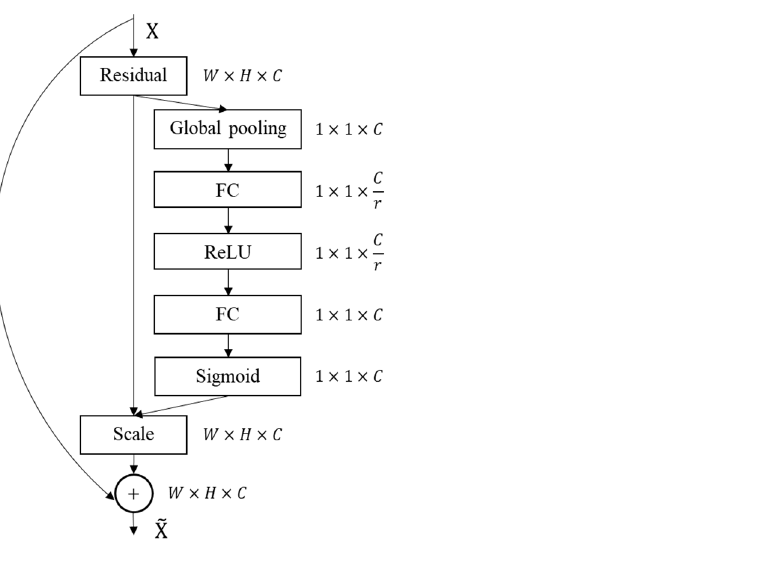
Figure 8. Residual block combined with the SE module. The SE module is composed of the residual block, which was introduced in Figure 5, global pooling block, full connection (FC) block, rectified linear units (ReLU) and activation block (Sigmoid).